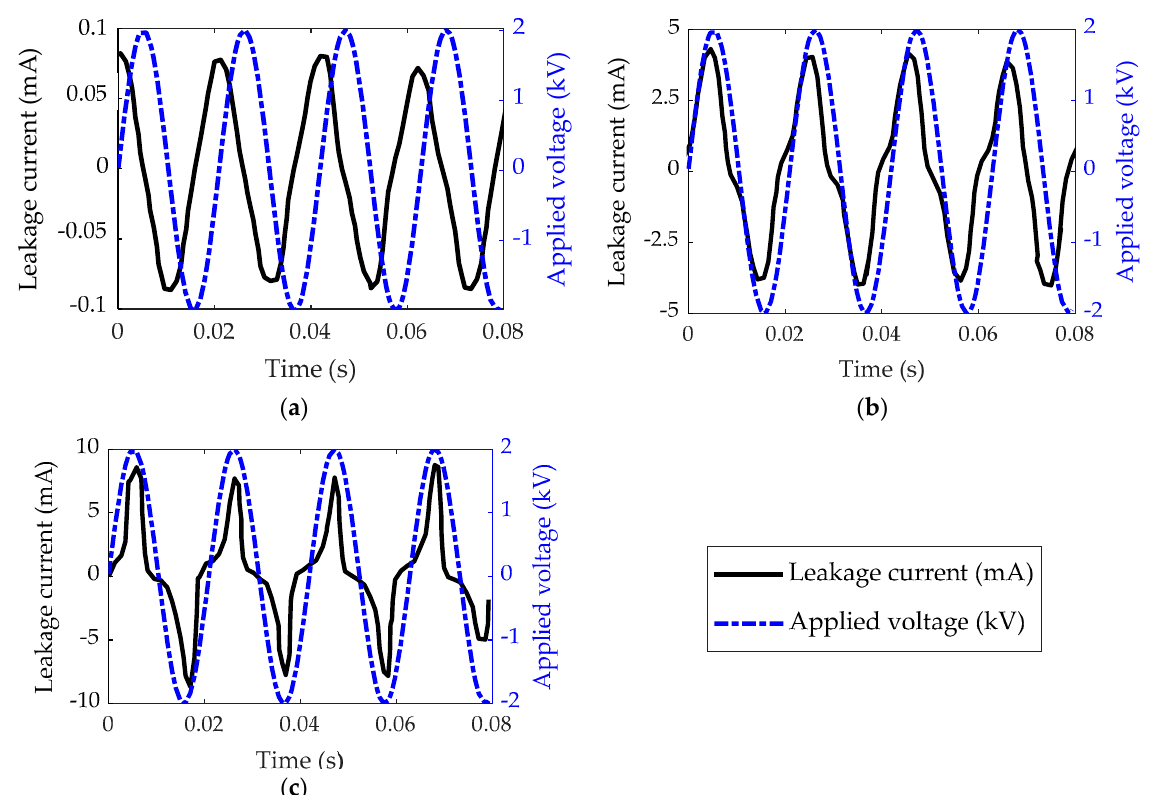
Figure 6. Waveforms of applied voltage and leakage current for insulator type II under different conditions: ( a ) Clean; ( b ) Polluted with fog wetting; ( c ) Polluted with rain wetting rate of 3 L/h.